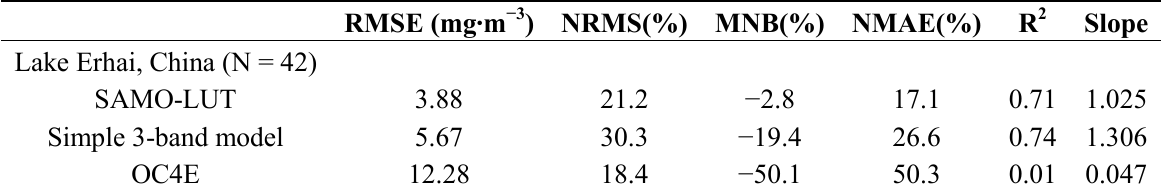
Table 4. Performance of the SAMO-LUT, Simple 3-band Model and OC4E for the estimation of Chl- a in Lake Erhai,